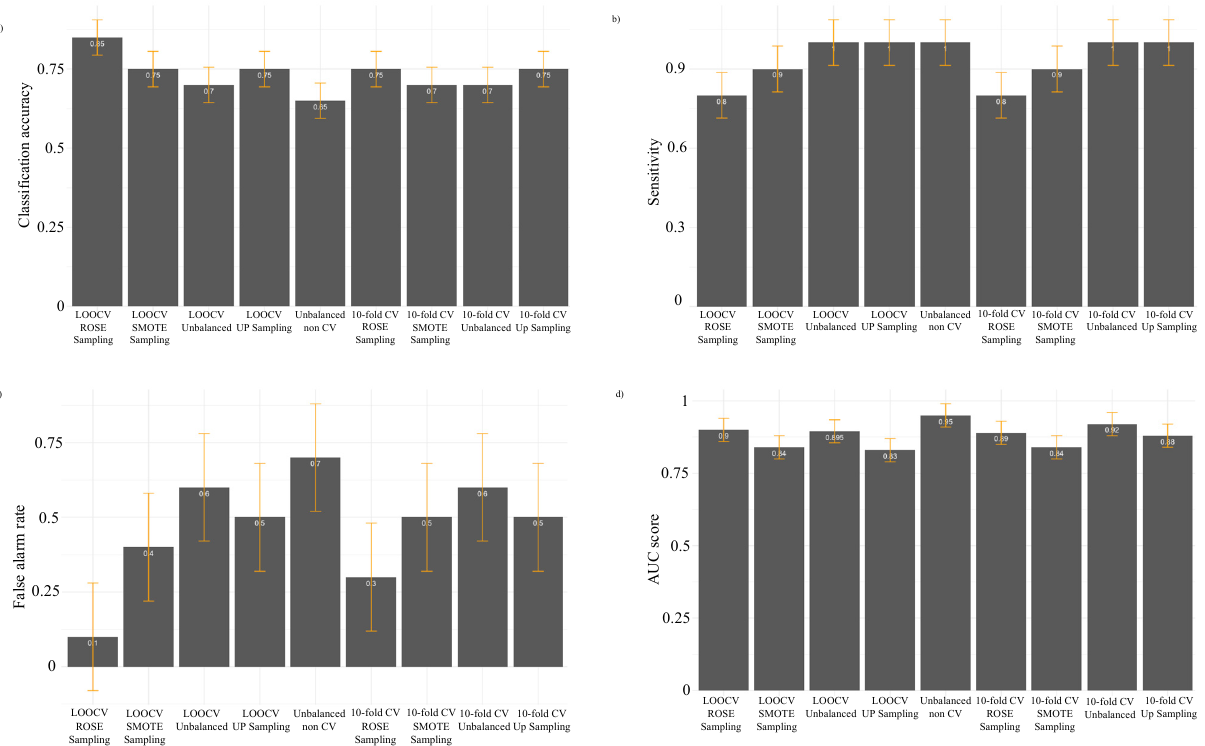
Figure 8. The comparisons of ( a ) classification accuracy, ( b ) sensitivity, ( c ) false alarm rate (FAR), and ( d ) AUC score of nine different random forest models using the testing data for island landfall. White color values on the top of each bar indicate the model performance for the particular matrices. The yellow lines are defining the error bars. Table 6. Confusion matrix for the testing dataset produced from the LOOCV with ROSE sampling random forest with members trained using binary classes for island landfall .